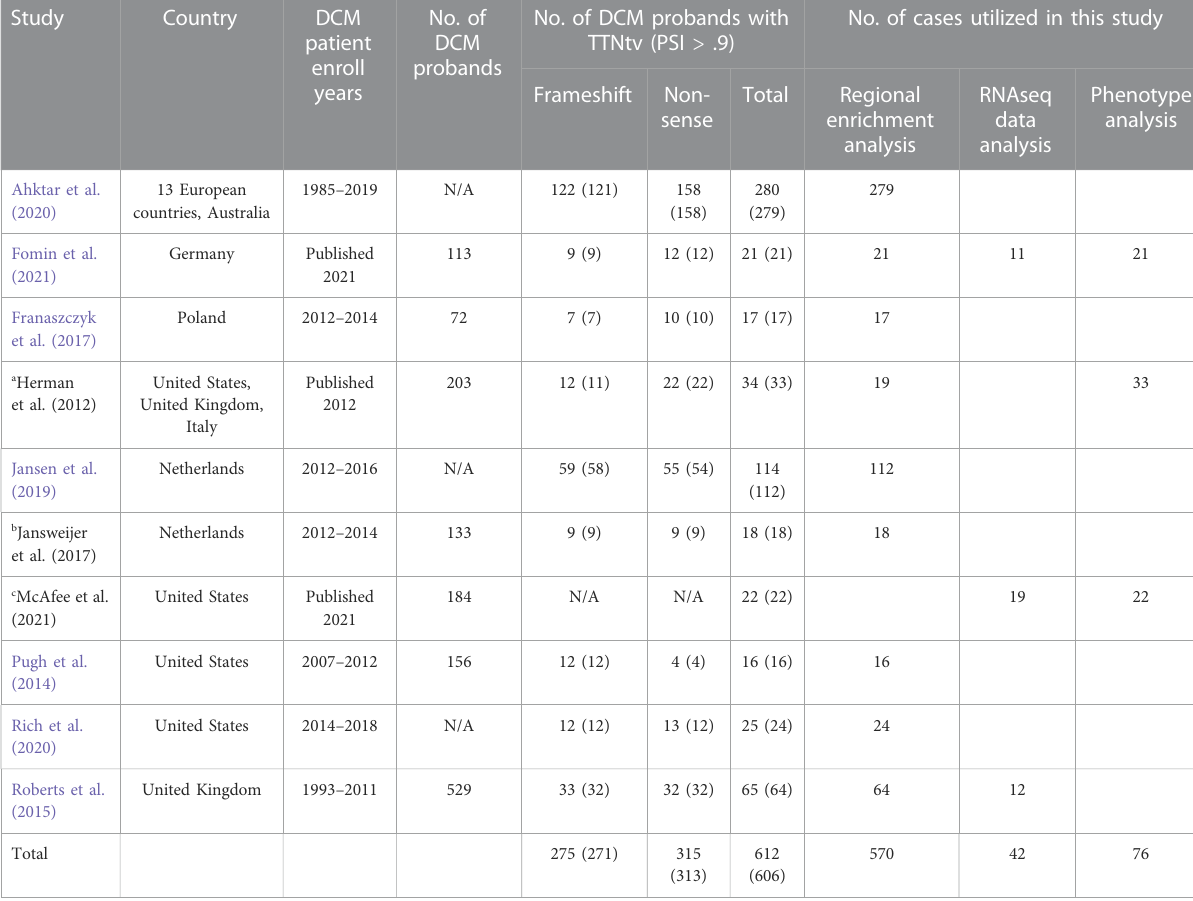
TABLE 1 List of research papers utilized and the number of TTNtvs from each study.